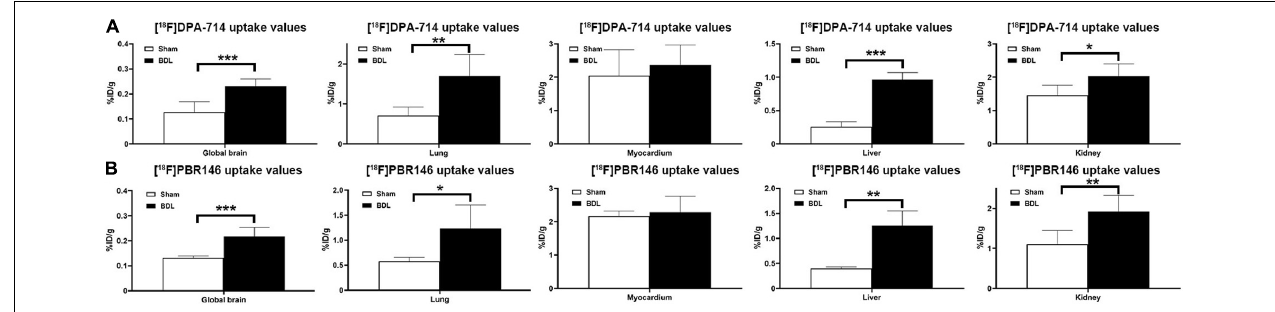
FIGURE 1 | Histograms of uptake values in global brains and organs of sham and BDL rats. The [ 18 F]DPA-714 uptake values in global brain and several organs (A) similar to that of [ 18 F]PBR146 uptake values, (B) global brain, and most organs showed significantly differences between Sham and BDL rats except myocardium. BDL = bile duct ligation; * P < 0.05, ** P < 0.01, and *** P <